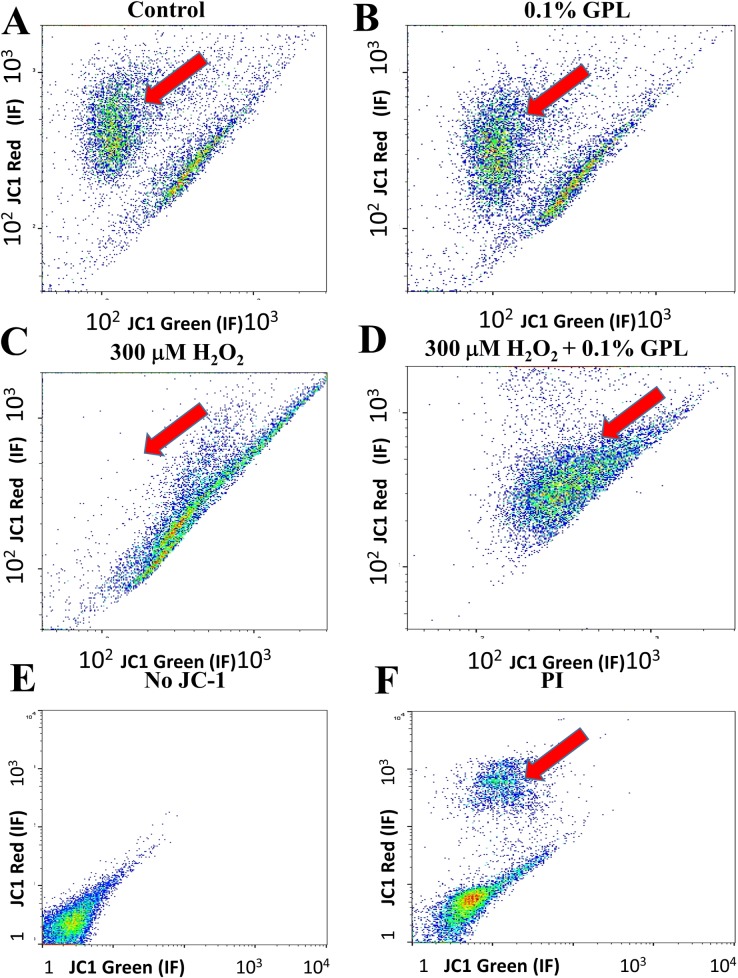
Dot plots from flow cytometry of sperm loaded with JC-1, a mitochondrial reporter, under different experimental conditions.(A) Results obtained after control incubation of sperm. (B) Incubation of sperm with 0.1% GPL. (C) Incubation of sperm with 300 μM H2O2. (D) Incubation of sperm with 300 μM H2O2 with the addition of 0.1% GPL. (E) Control obtained with unstained sperm (without JC-1). (F) Cells stained with JC-1 and exposed to the toxic molecule PI.